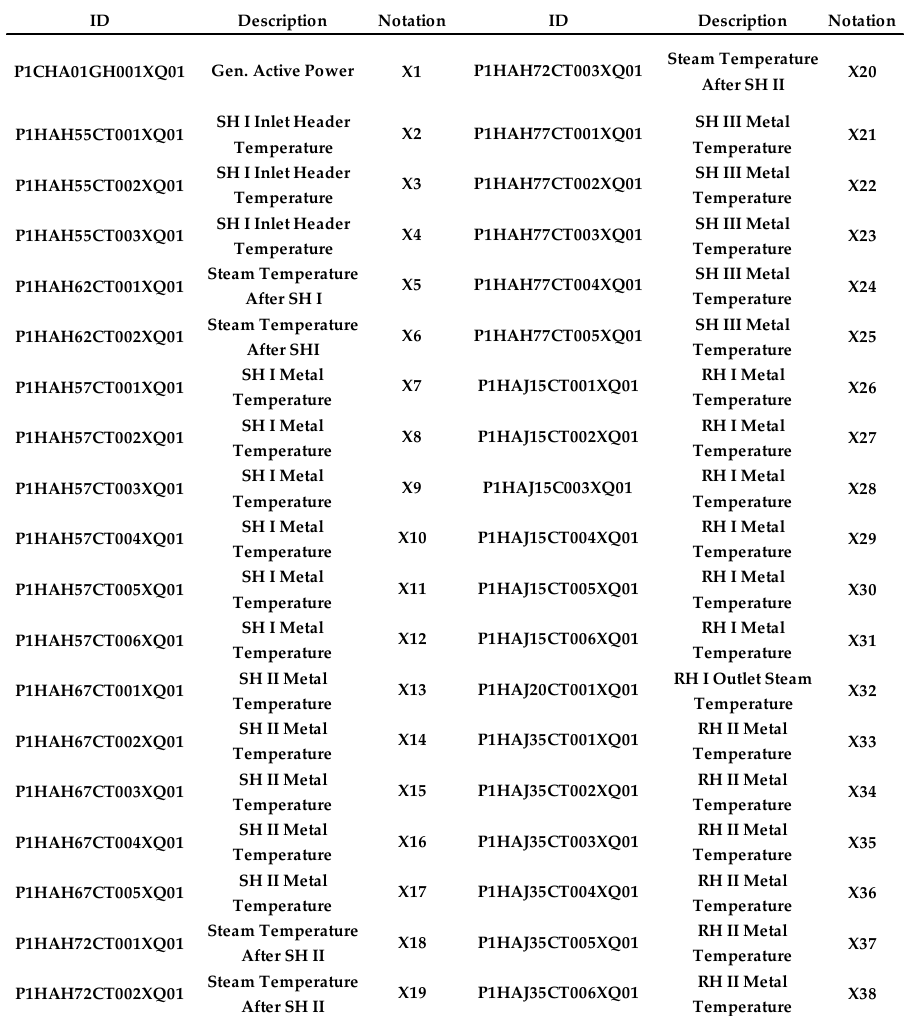
Figure A1. Summary of the sensitive sensor data from thermal power plant boiler water wall tube leakage detection.